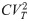
Scaling of noise as a function of the mean protein level for different mechanisms.The contribution of random cell-division events to the noise in protein copy numbers (extrinsic noise) is invariant of the mean. In contrast, contributions from partitioning errors at the time of cell division (partitioning noise) and stochastic expression (production noise) scale inversely with the mean. The scaling factors are shown as a function of the protein random burst size B, noise in cell-cycle time (CVT2) and magnitude of partitioning errors quantified by α (see Eq (5)). With increasing mean level the total noise first decreases and then reaches a baseline that corresponds to extrinsic noise. For this plot, B is assumed to be geometrically-distributed with mean 〈B〉 = 1.5, CVT2=0.05 and α = 1 (i.e., binomial partitioning).